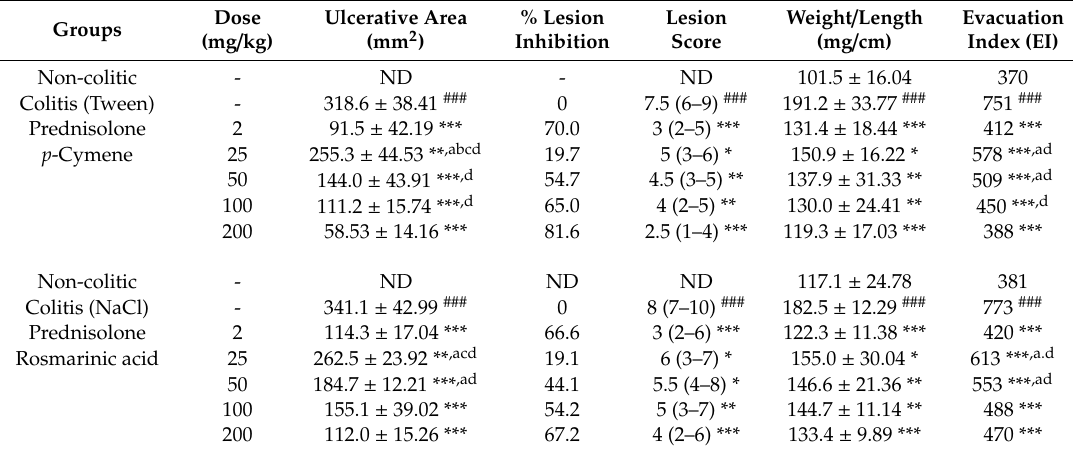
Table 1. E ff ect of oral administration of p -C and RA in the acute phase of trinitrobenzene sulfonic acid (TNBS)-induced intestinal inflammation. Data are expressed as mean ± SD or median (minimum / maximum